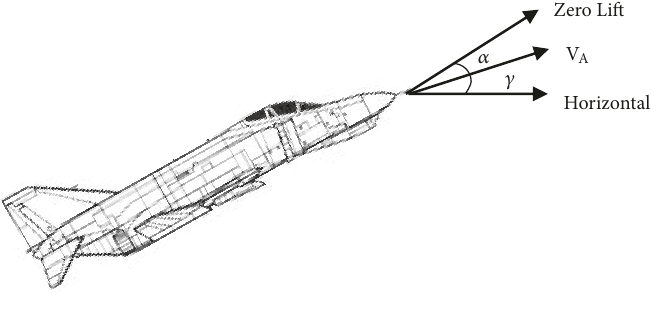
Figure 3: Aircraft illustration (longitudinal motion).